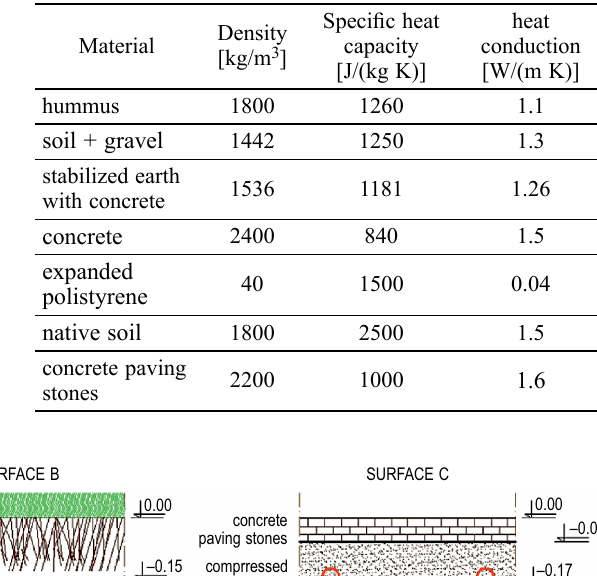
Table 1. Thermal physical properties of the materials used in the numerical model